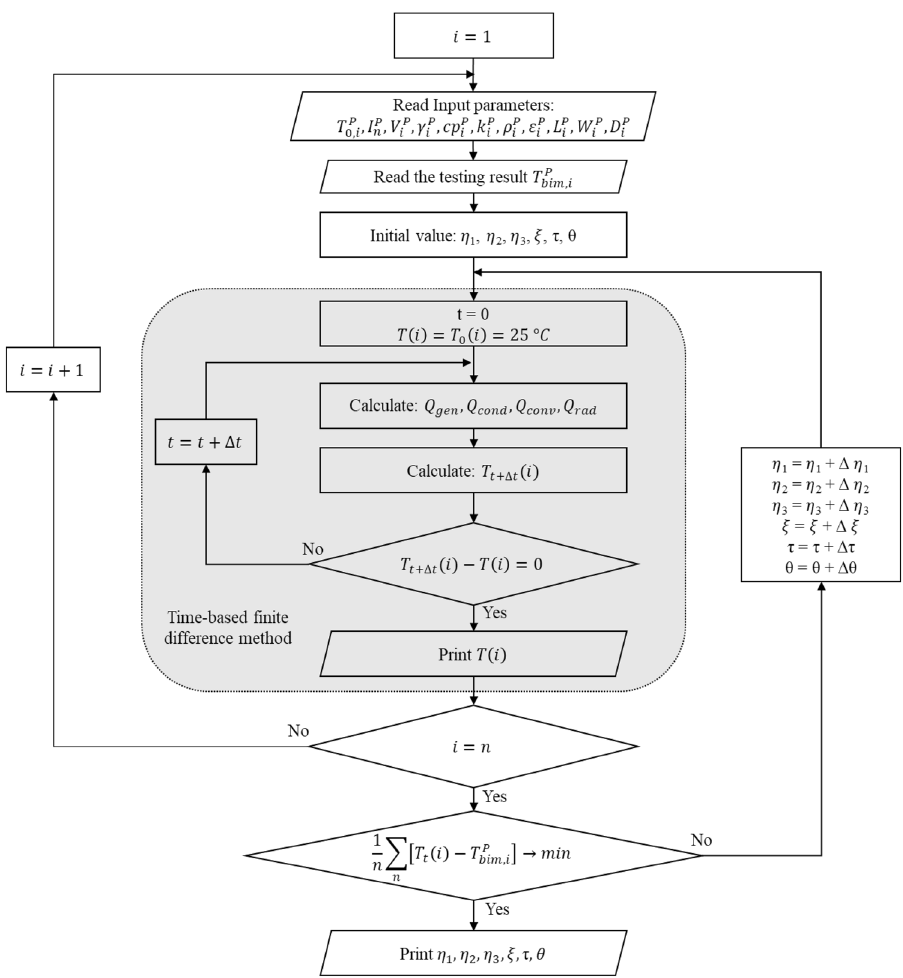
Figure 4. Algorithm flowchart of the NMML model.